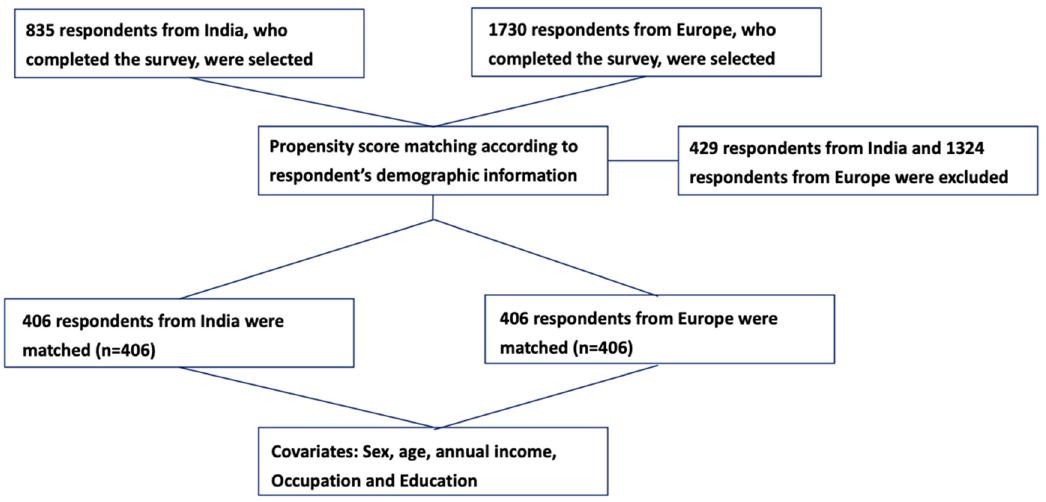
Figure 1. The Flow Chart of Propensity Score Matching.